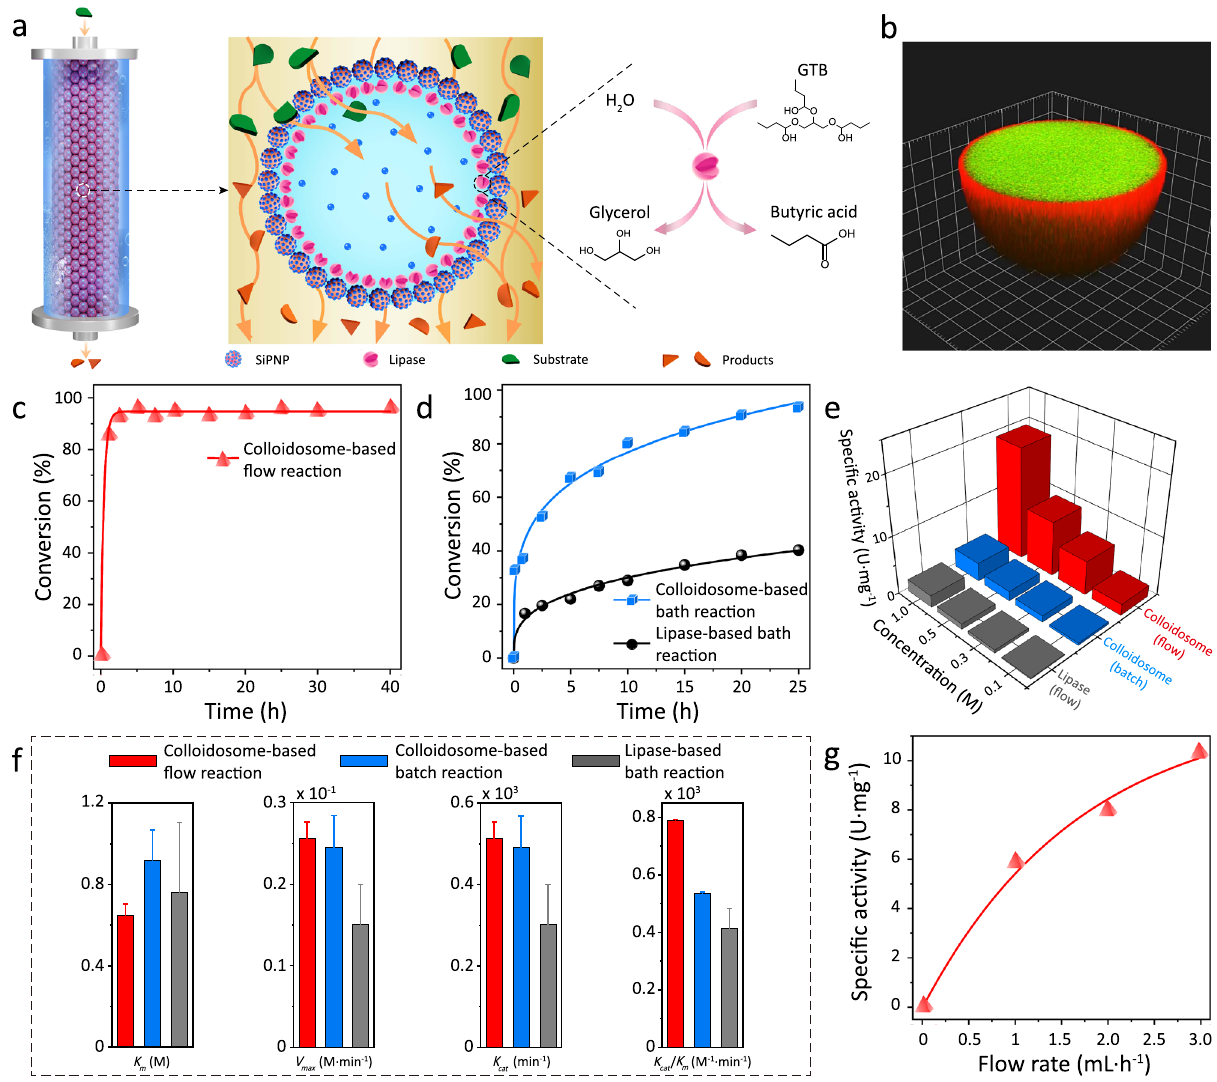
Fig. 4 Lipase-catalyzed GTB hydrolysis in a column reactor packed with three-tiered colloidosomes. a Scheme showing the continuous in fl ux of lipase substrates (i.e., GTB) into the three-tiered colloidosomal microreactors in a column containing mobile oil phase, where the ester hydrolysis took place on the catalytic layer to generate the product ef fl ux (i.e., glycerol and butyric acid). b 3D-reconstructed image of the three-tiered colloidosomes with RhITC- lipase catalytic layer (red fl uorescence) and the substrate-enriched lumen (NBD-PE here as example, green fl uorescence). Grid width: 4 μ m. c , d Time- dependent conversion for GTB (0.5 M in isooctanol) hydrolysis in the colloidosome-based fl ow reaction, loaded lipase: 0.84 mg ( c ); colloidosome- and lipase-based bath reactions, loaded lipase: 0.21 mg ( d ). A comparison revealed the high ef fi ciency and stability of the fl ow system. The concentration of GTB was calibrated according to the constructed calibration plots and corresponding equations (Supplementary Fig. 23). e Speci fi c activity (SA) values of lipase in the colloidosome-based fl ow reaction at steady state (1 mL h − 1 ), and colloidosome- and lipase-based bath reactions within 20 h, respectively. f Comparison of the Michaelis – Menten kinetic parameters, k m , v max and k cat , k cat / k m , for the colloidosome-based fl ow reaction, and colloidosome- and lipase-based bath reactions, respectively. Error bars indicate the SD of three replicating measurements. g SA plot of lipase in the colloidosome-based fl ow reaction against fl ow rate (substrate concentration of 0.3 M), showing the larger SA resulted from the higher fl ow rate of the oil mobile phase. The column temperature for all experiments in the fl ow system was set as 40 °C. The fl ow rate for all fl ow reactions was 1 mL h − 1 , except for g